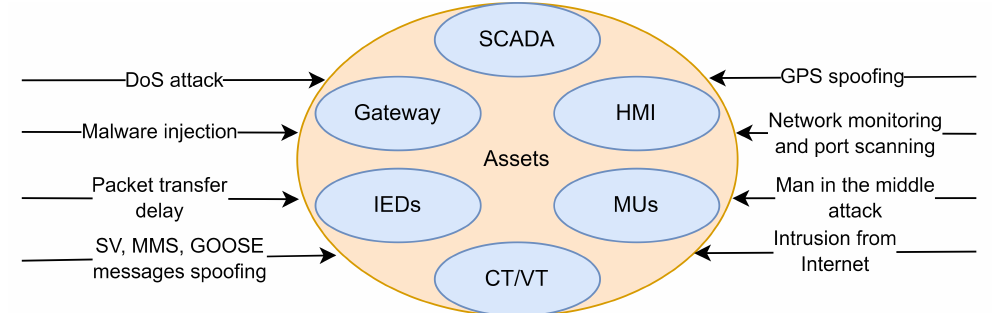
Figure 3. Potential assets and threats to be analyzed. Adapted from